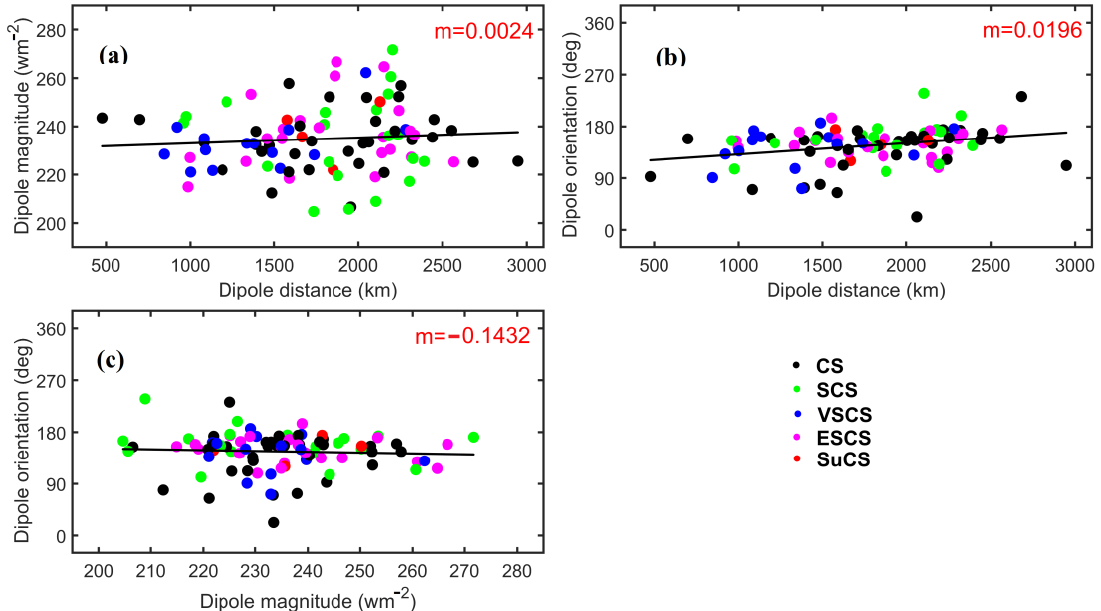
Figure 9. Scatterplot represents the linear variation in dipole characteristics ( a ) dipole distance vs. dipole magnitude, ( b ) dipole distance vs. dipole orientation, and ( c ) dipole magnitude vs. dipole orientation. Different colours represent each category of tropical cyclones.